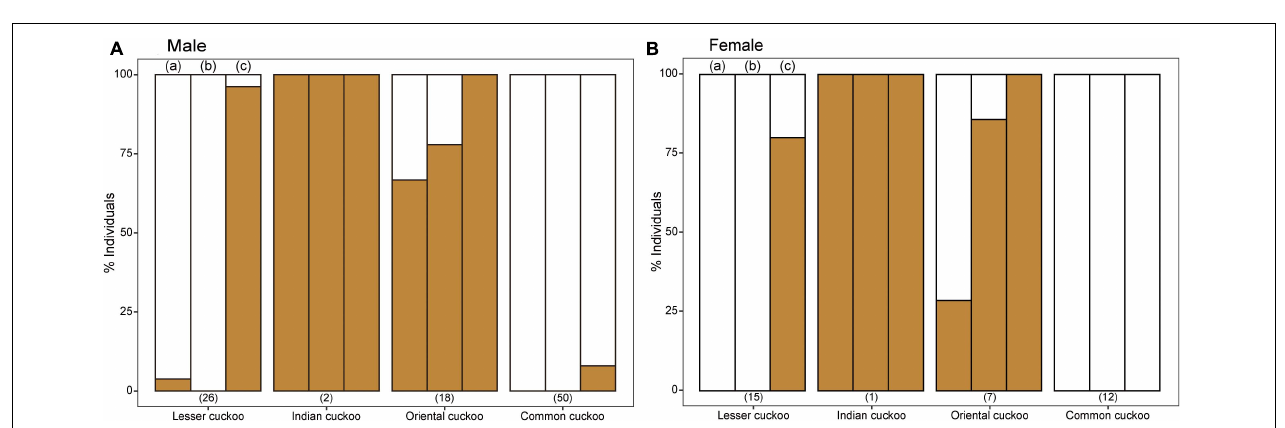
FIGURE 3 | The R and G values of iris (A) and eye-ring color (B) in the four Cuculus cuckoos. Among the RGB color code, for visual understanding, only R and G values are represented. The color bar in the box represents the approximate color of iris and eye-ring of the observed combination of R and G values. The shapes and colors of dots are different according to species. LC, lesser cuckoos; IC, Indian cuckoos; OC, oriental cuckoos; CC, common cuckoos.